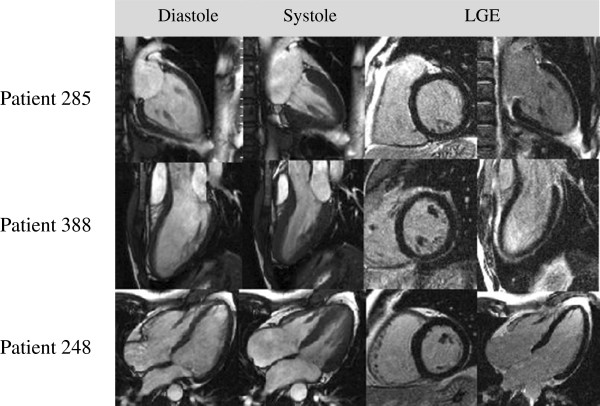
CMR images of patients with different symptoms and histories suggestive of myocarditis. Patient 285: 48-year-old female referred by a cardiologist for work-up of dyspnea, chest pain and abnormal fatigue, occurring after a viral infection. Patient 388: 28-year-old male who presented with palpitations, chest pain and abnormal fatigue after sinusitis. ECG showed ST-elevations suggestive of myocarditis. Patient 248: 49-year-old male, suffering from dyspnea, palpitations and ventricular extrasystoles following viral gastroenteritis. All these patients had normal CMR results, and in follow-up, there were no cardiac events in any of these patients. At follow-up, all were without any cardiac symptoms.